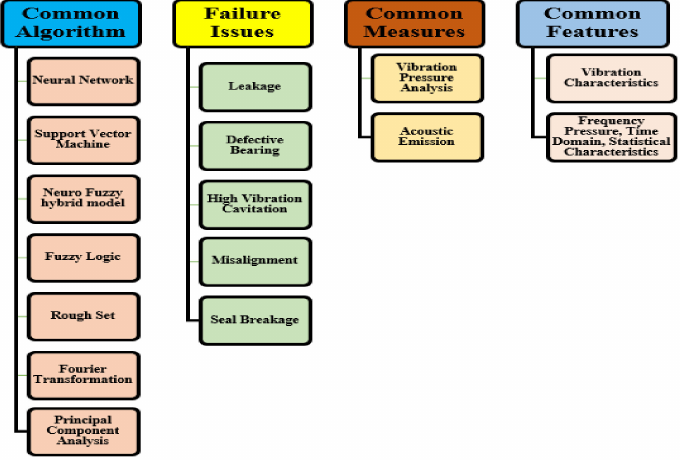
Figure 16. Common machine learning tools in pump